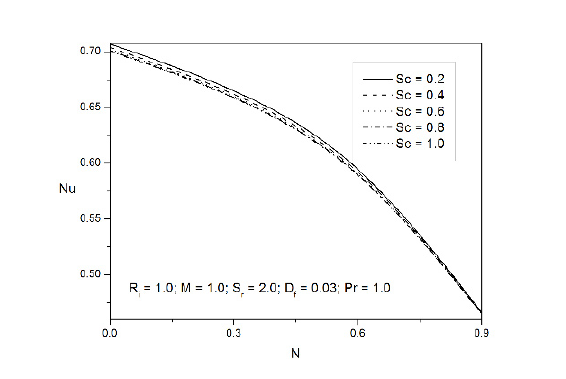
Figure 10. Effect of Prandtl number Pr on Heat Transfer Rate